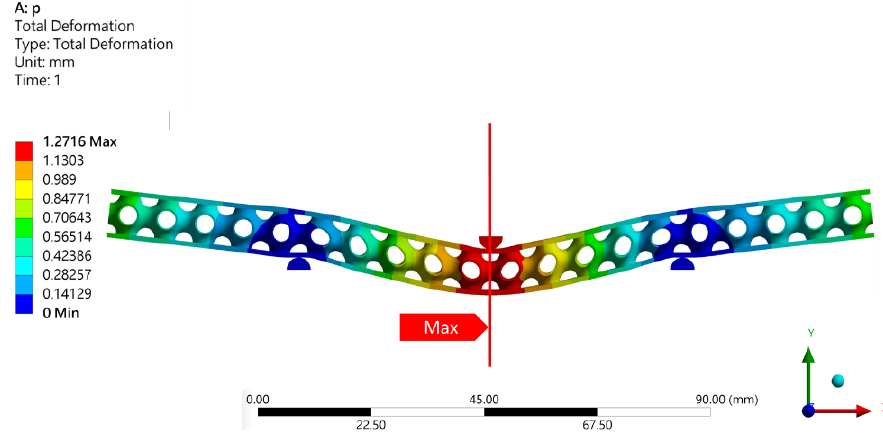
Figure 9. Deformation distribution of SPSs with SP lattice cores.